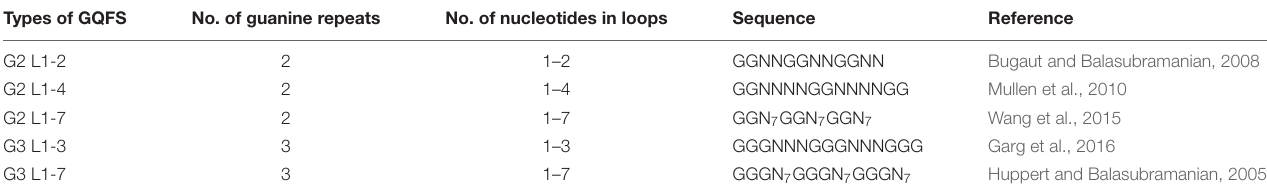
TABLE 1 | Different types of G quadruplexes forming